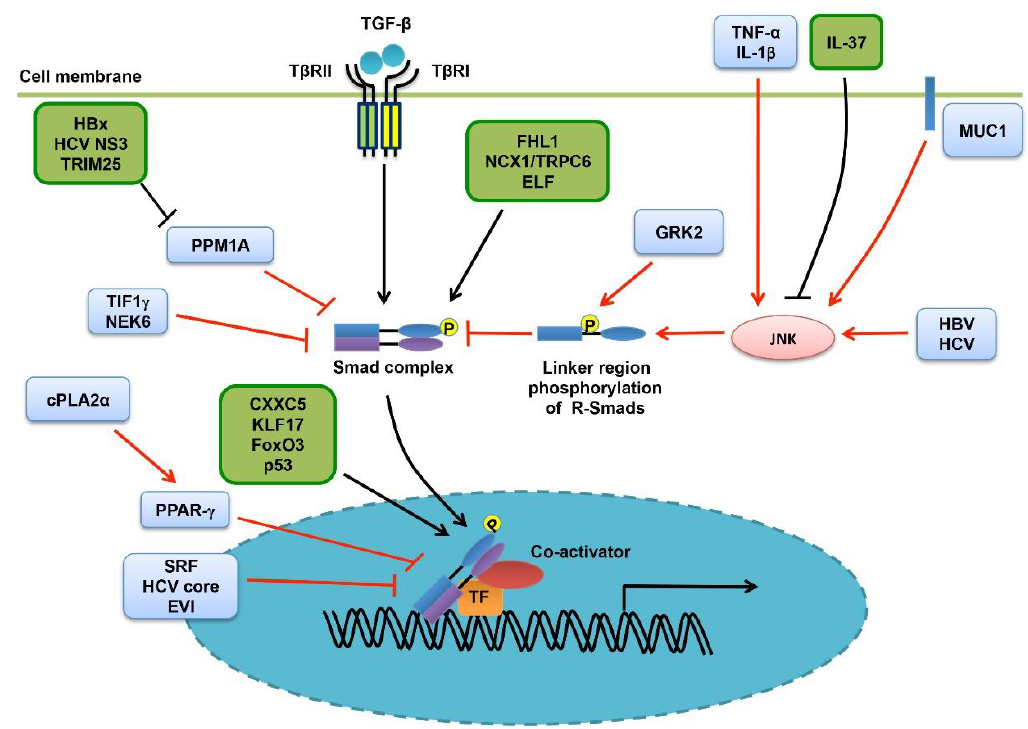
Figure 5. Controlling the activity of Smad proteins in liver cancer. The signaling activity and transcriptional activity of Smads are well controlled by PTMs. FHL1 promotes Smad activity by inducing their C-terminal phosphorylation, independent of TGF- β receptors. In contrast, the phosphatase PPM1A specifically targets Smad2 / 3 by counteracting TGF- β -induced phosphorylation. Interestingly, HBx, HCV NS3 and TRIM25 could enhance Smad signaling by promoting PPM1A degradation. Extracellular TNF- α and IL-1 β , the membrane-bound protein MUC1, and also HBV / HCV, are able to promote JNK-mediated linker region phosphorylation in R-Smads, thereby impelling Smad signaling. Differently, IL-37 may promote the signaling activity of R-Smads by reducing their linker region phosphorylation. Furthermore, GRK2 could also phosphorylate R-Smads at their linker regions in liver cancer. Unlike the above, both TIF1γ and NEK attenuate TGF-β signaling by inhibiting Smad4. NCX/TRPC6 and ELF are required for Smad signaling by regulating